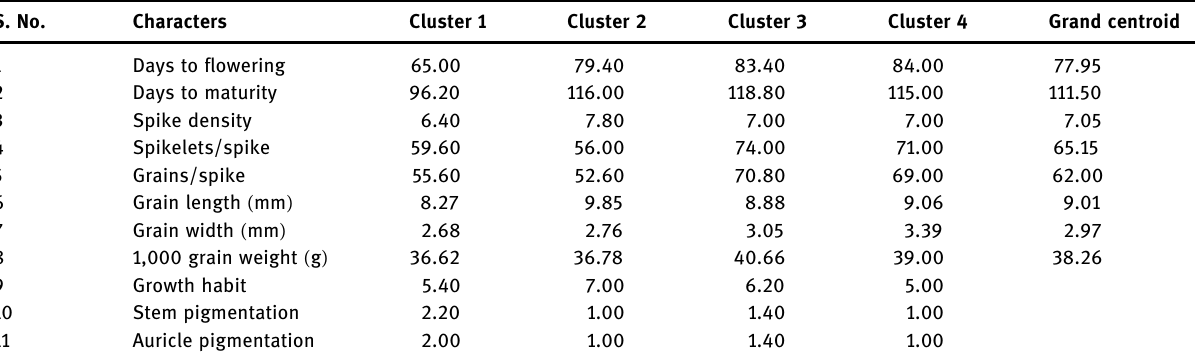
Table 6: Mean values of morpho - agronomic characters and anthocyanin pigmentation in two plant parts of four clusters of 16 indigenous barley